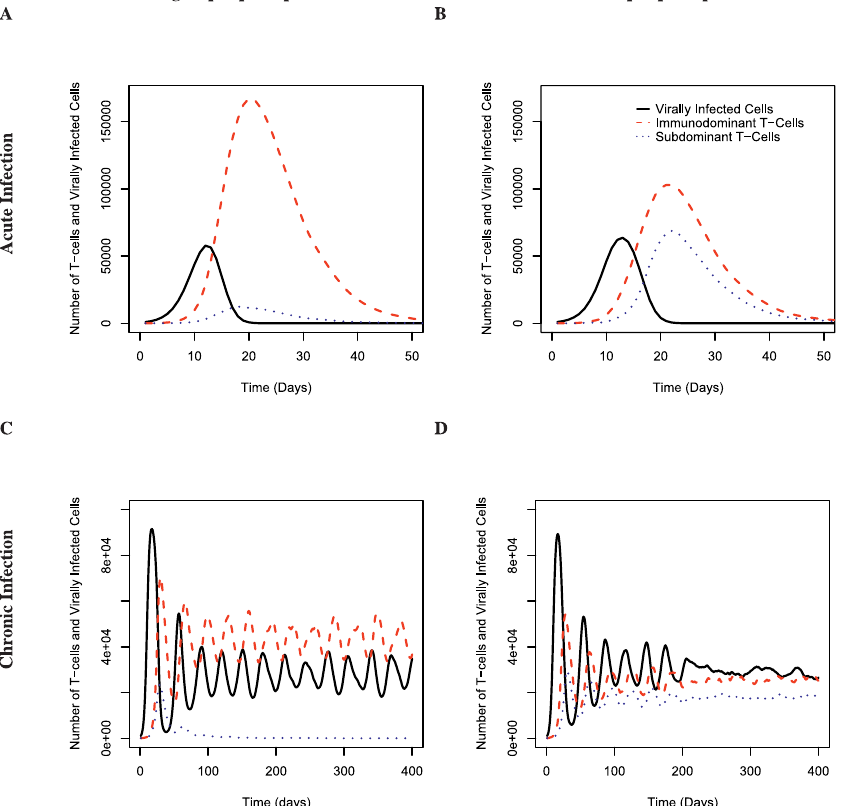
Figure 2. T cell Dynamics in Acute and Chronic Infection In these simulations, two epitopes of a pathogen are displayed at equal densities on APCs. The number of epitope copies required for T cell activation is set to 50 copies, and APCs have six T cell binding sites. (A and C) Both epitopes are displayed at high expression levels of 300 copies each (per APC). (B and D) Both epitopes are displayed at low expression levels of 150 copies each. Acute infection is modelled by assuming a higher proliferative capacity of T cells in acute than in chronic infection, namely seven versus five rounds of proliferation, respectively. T cell affinities are set to 0.07 and 0.1 for the subdominant and immunodominant T cell specificity, respectively. All other parameter settings are listed in Table 1. DOI: 10.1371/journal.pcbi.0020109.g002